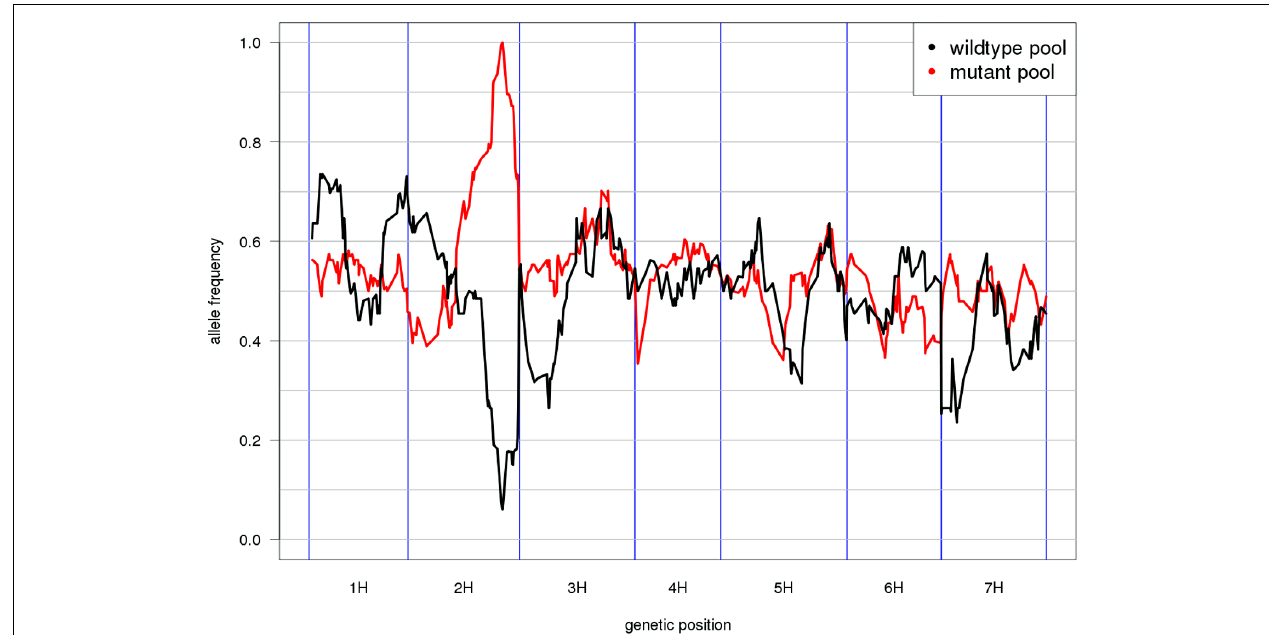
population. The bulks were defined by presence or absence of the zeocriton (compressed ear) phenotype. Eighty-two OWB individuals were sequenced as part of POPSEQ and phenotypes were assigned based on publicly available phenotypic data (Carollo etal., 2005). The peak coincides with the genetic position of the gene ZEOCRITON (2H, 127 cM; Houston etal.,